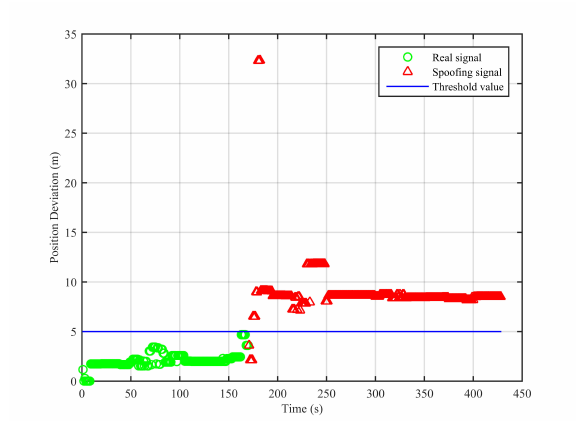
Figure 9. Position deviations of the two algorithms (static position spoofing scenario).